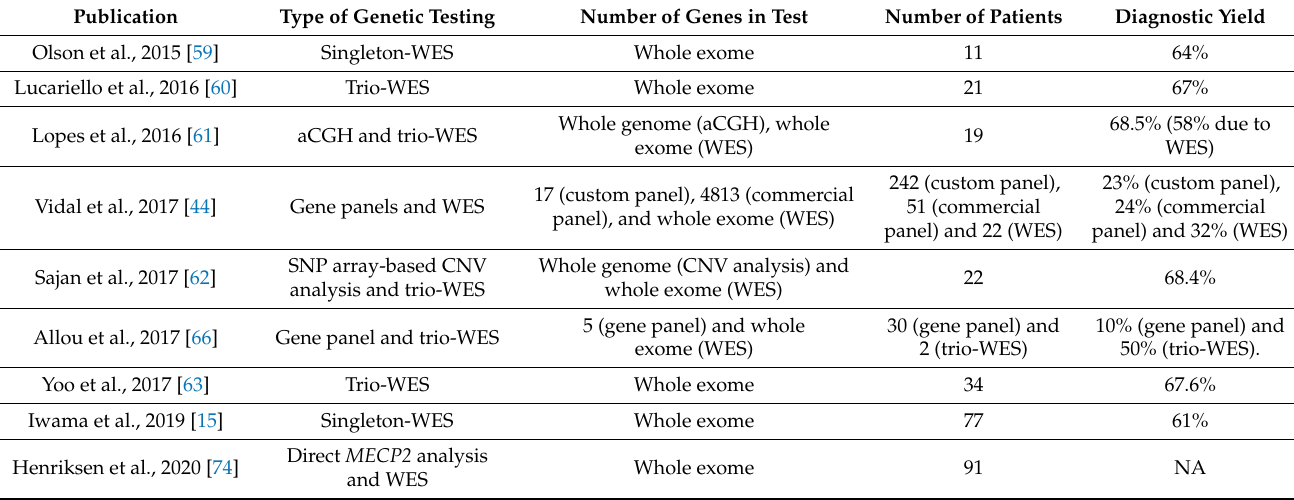
Table 2. NGS studies performed on RTT cohorts and their diagnostic